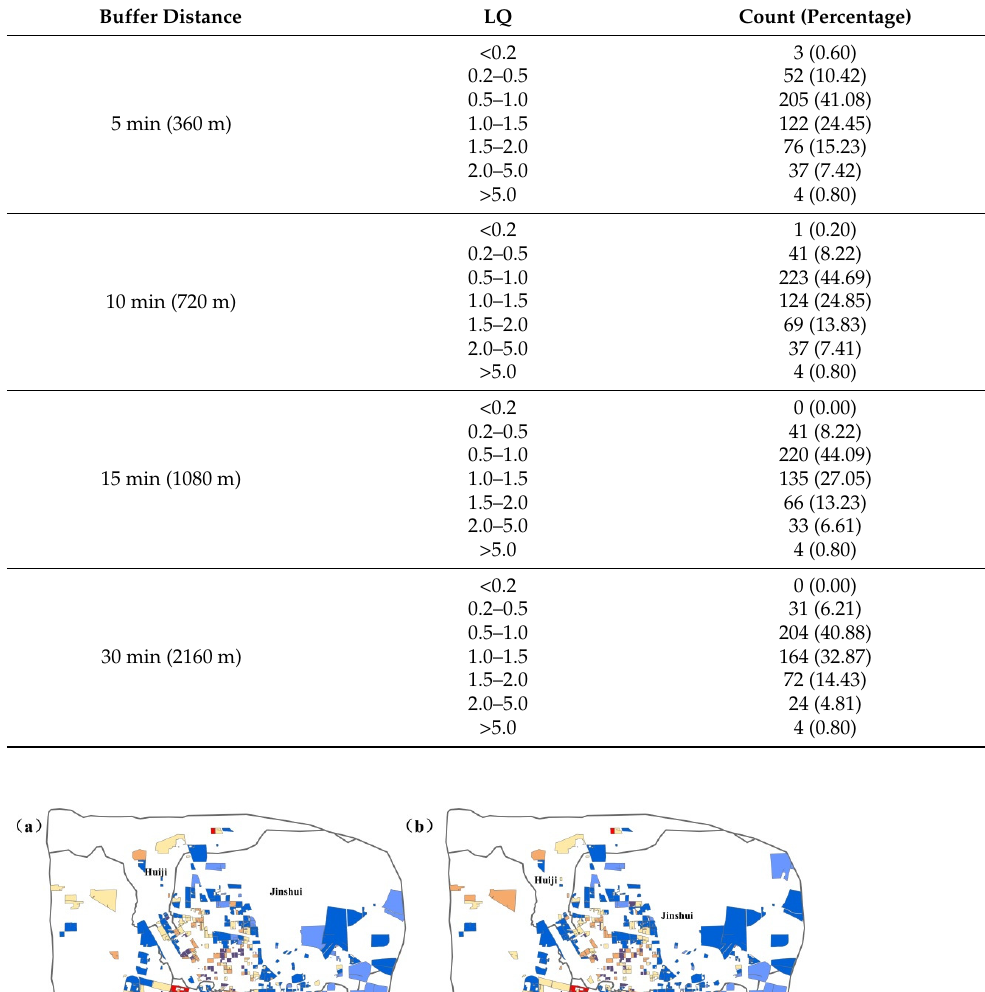
Table 1. Statistics of location entropy of each buffer distance (5 min, 10 min, 15 min, and 30 min).